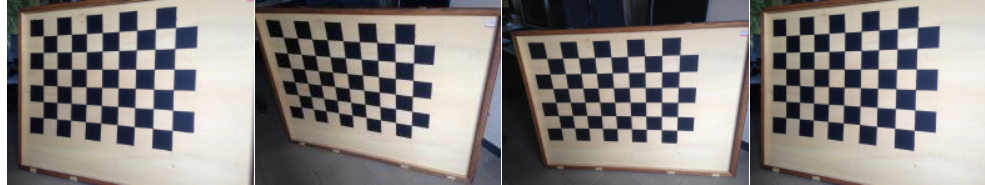
Figure 11. Some images of the checkerboard acquired by a smartphone for camera calibration.